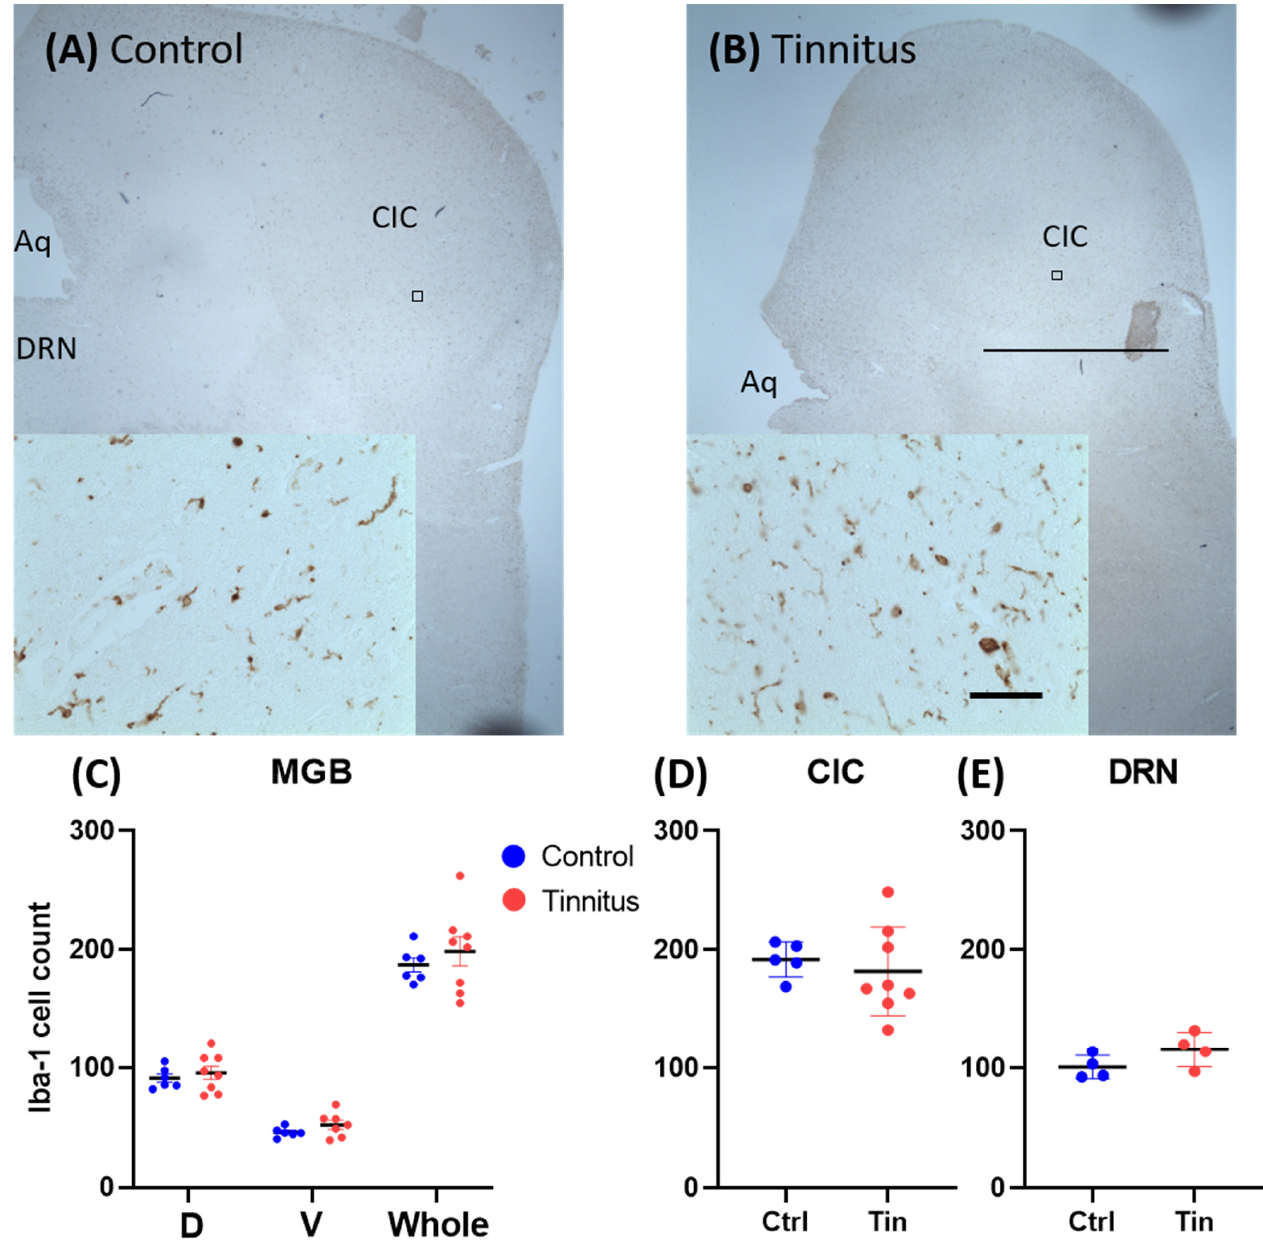
Figure 4. Iba-1 expression in the MGB, CIC, and DRN. ( A , B ) Photomicrographs of sections stained with Iba-1, taken from the adjacent sections shown in Figure 3. ( C – E ) Cumulative data showing the mean and SEMs of Iba-1 cell count. ( C ) Graph shows the Iba-1 cell count in the (D) dorsal, (V) ventral, and (whole) MGB in tinnitus and control subjects. p < 0.05 was defined as significant level. Note: no significant difference was found in any of the investigated regions when comparing the tinnitus group with controls. Scale bar = 2 mm; scale bar in the inset = 50 µ m. Aq, cerebral aqueduct; CIC, central part of inferior colliculus; DRN, dorsal raphe nucleus; and MGB, medial geniculate